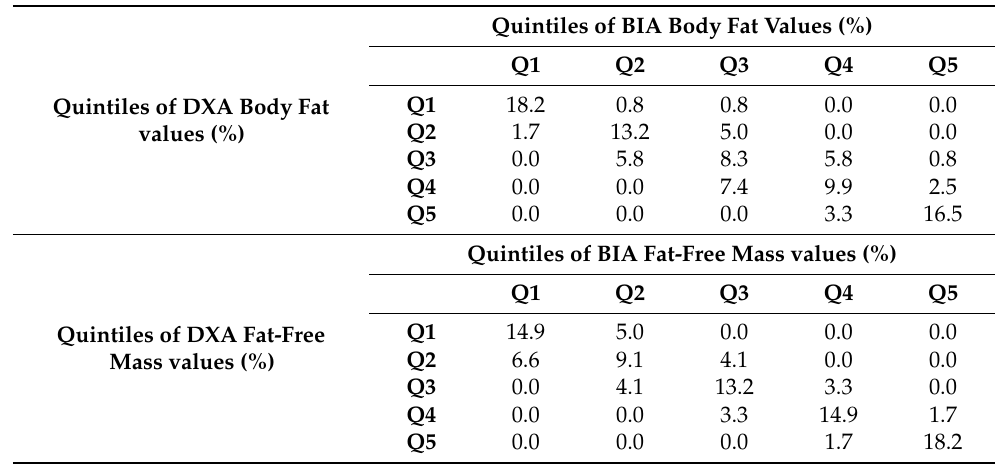
Table 4. Contingency tables for the percentage of misclassification between the quintiles of the two equipment (BIA and DXA) regarding body fat and fat-free